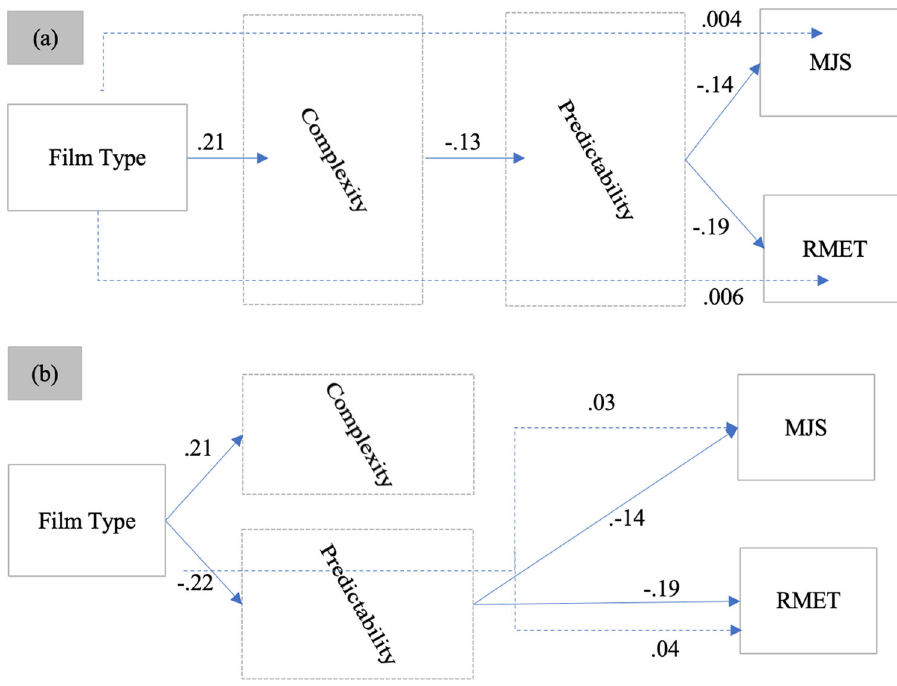
Fig. 1 Film Type: art = 1, Hollywood = − 1; MJS = moral judgment score; RMET = reading the mind in the eyes test. Coef fi cients reported are unstandardized b . Con fi dence intervals of all effects reported, do not include zero. Dotted arrow lines refer to indirect effects. Proposed sequential model ( a ) and alternative parallel model ( b